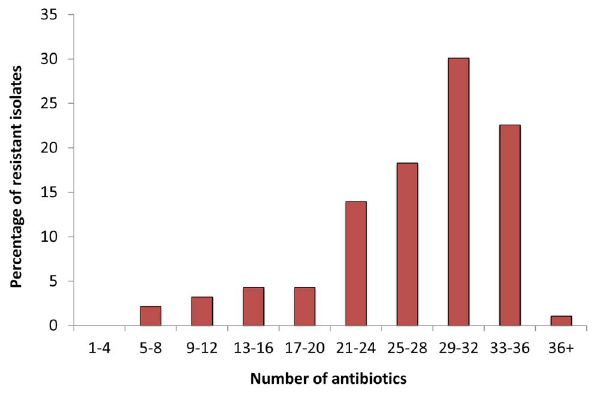
Figure 1. Multi-drug resistance observed among 93 bacterial strains isolated from the PETL WWTP. The X-axis indicates the number of antibiotics (of 39 tested) to which the strains are resistant; the Y-axis indicates the percentage of resistant strains of 93 strains. The resistant and intermediately-resistant phenotypes are grouped together and denoted as